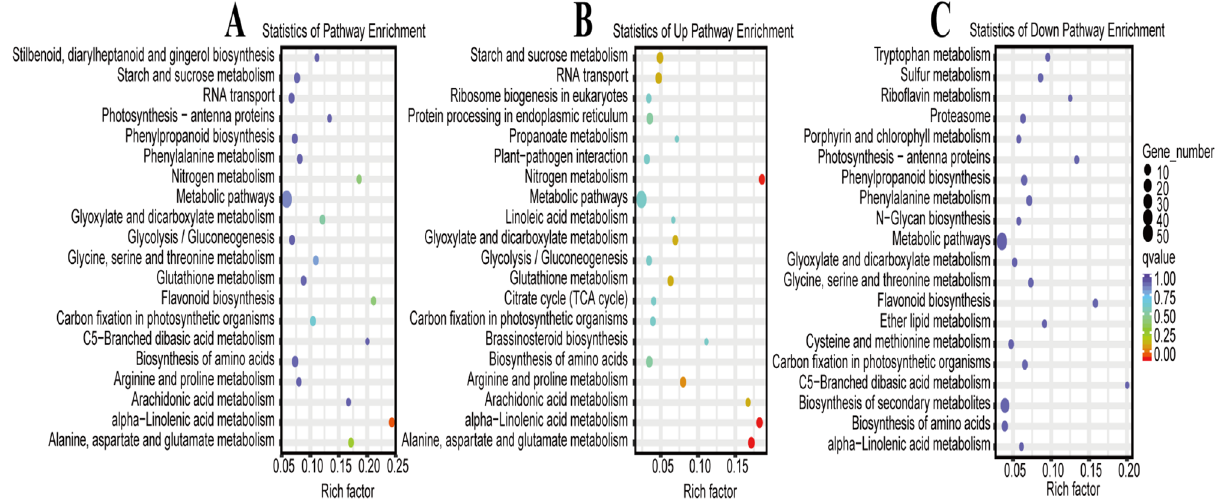
Figure 4. Gene pathway analysis of combined transcriptome and proteome analyses. ( A ) All genes, ( B ) Up-regulated genes, ( C ) Down-regulated genes. The sizes of the dots represent the gene numbers of each row, and p values were calculated from hypergeometric tests. plot generated using the ‘ggplot2’ packages in R 31,32